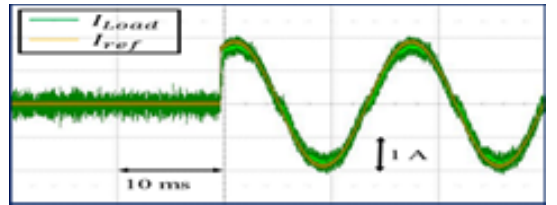
Figure 7. Experimental response of the current regulator implemented for the proposed system.